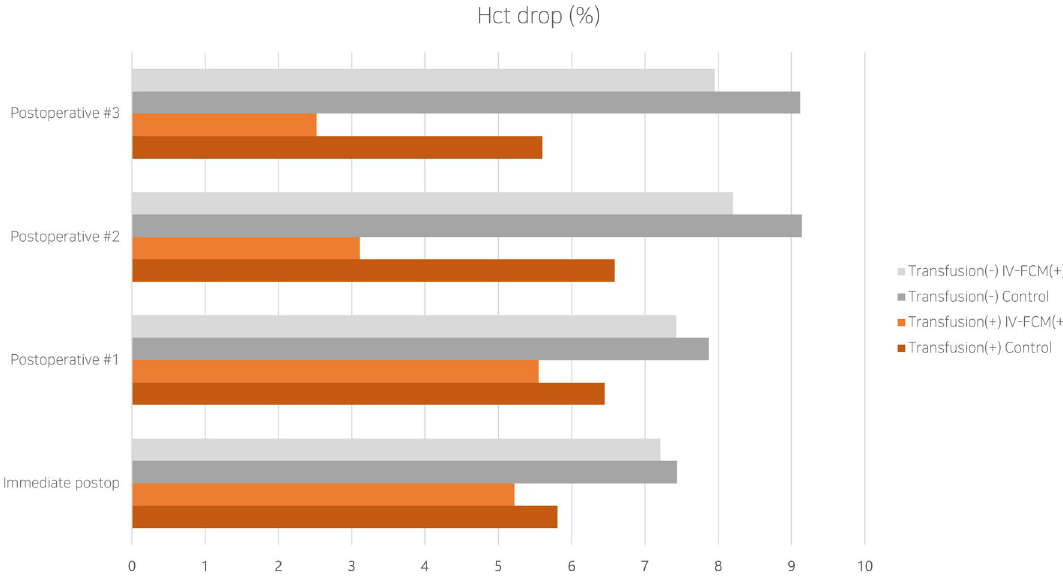
Figure 4. Change of hematocrit percentages illustrated graphically. The difference between the IV-FCM and control groups in terms of RBC transfusion was significant on postoperative days #2 and #3